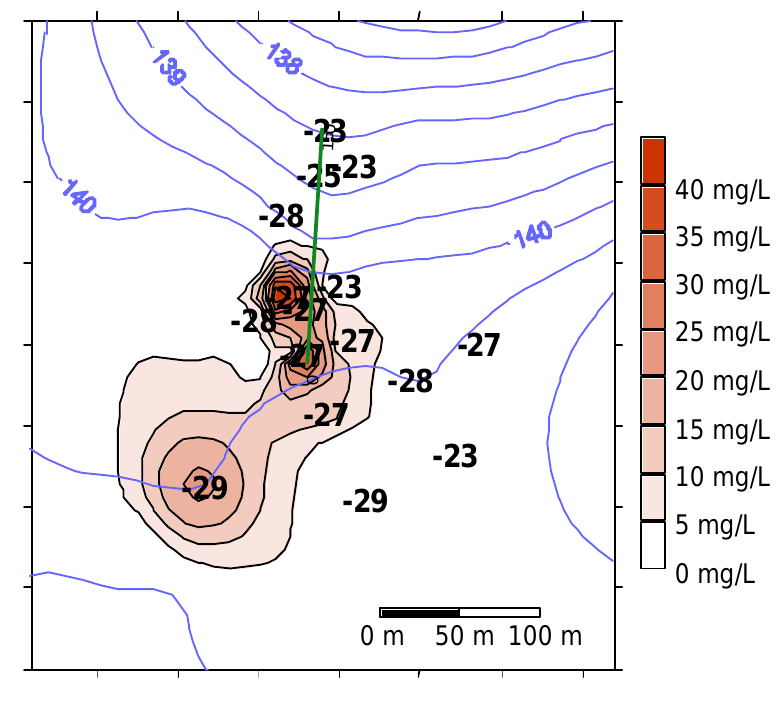
FIGURE 2. Concentration and isotopic composition of toluene in the upper aquifer in Zeitz, Germany. The blue lines indicate the depth of the groundwater table above the sea level (m). Black figures show the location of monitoring wells and the isotopic composition of toluene. The green line shows the position of the monitoring profile depicted in Fig.